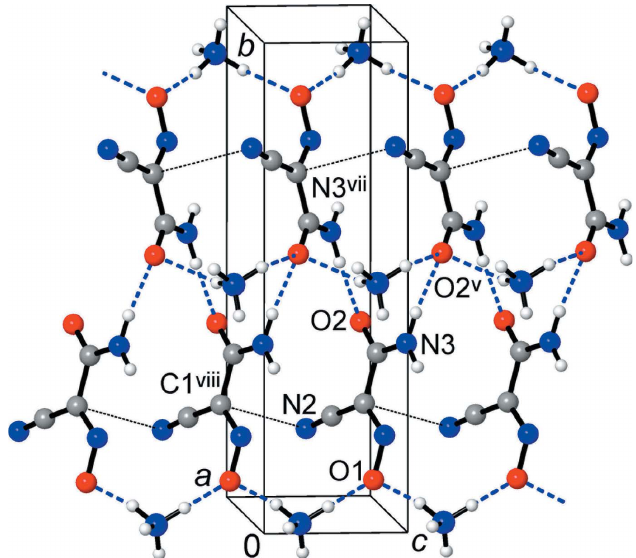
Figure 3 Mutual bonding of CONH 2 groups, which yields 2 1 helices propagating along the c -axis direction. Stacking interactions [ e.g. N2 (cid:2)(cid:2)(cid:2) C1 viii ] are indicated with thin lines [symmetry codes: (v) (cid:3) x , (cid:3) y + 1, z + 1